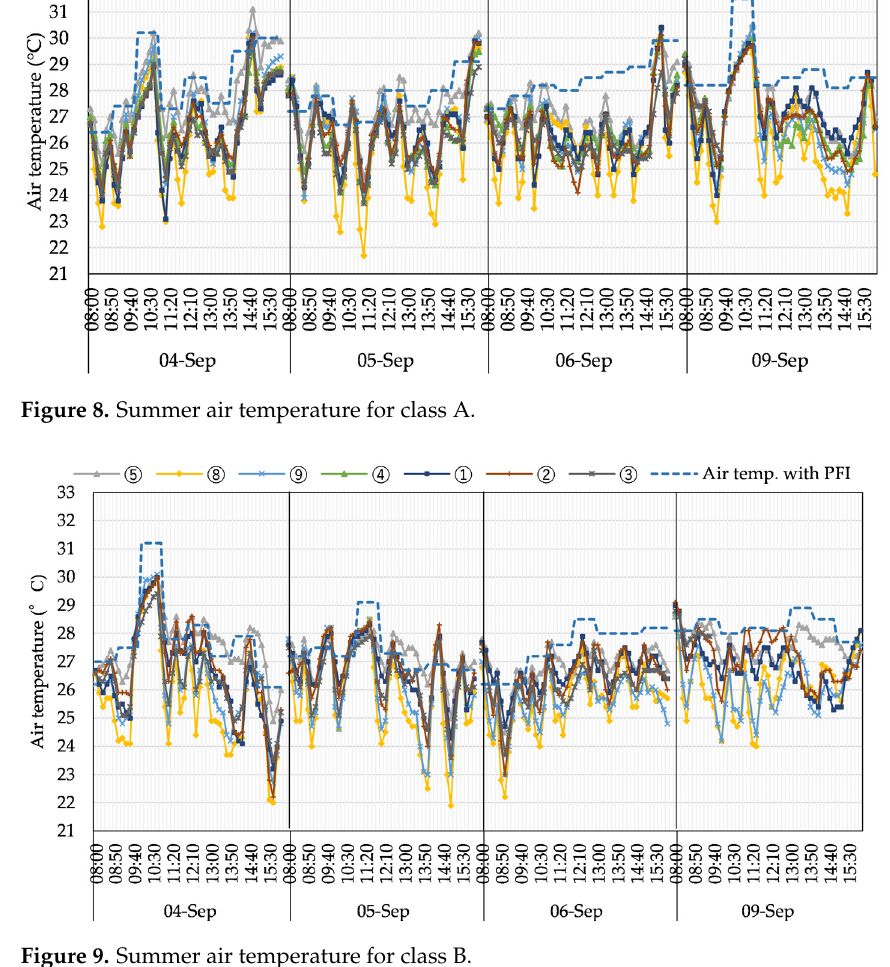
Figure 9. Summer air temperature for class B.